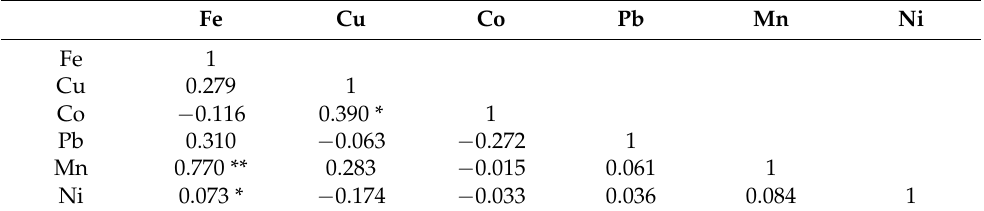
Table 5. Correlation between metal concentrations in sediment and soft tissue of shellfish.